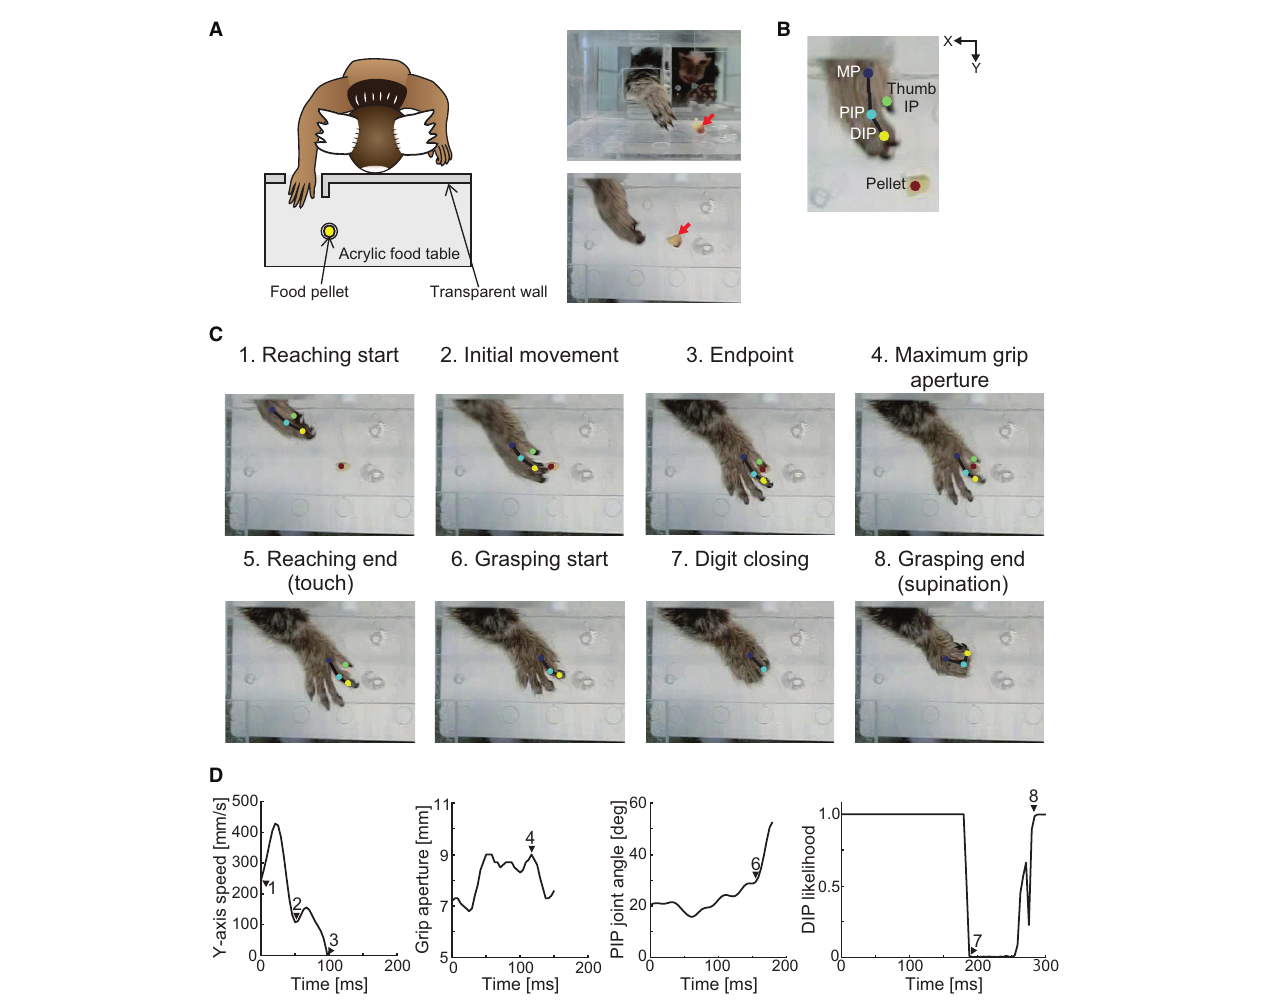
FIGURE1 Schematic of the experimental setup and definition of the movement phase. (A) Experimental setup. Red arrows in the right images indicate the position of the food pellet. (B) Positions of the tracking using DeepLabCut. Two-dimensional positions of the distal interphalangeal (DIP), proximal interphalangeal (PIP), and metacarpophalangeal (MP) joints of the index finger, interphalangeal (IP) joint of the thumb, and food pellet were tracked. (C) Definition of the movement phases. The reaching movement phase was defined as the time at which the MP joint of the index finger passed the opening (“reaching start”) to the time when the hand touched the food pellet (“reaching end”). The grasping movement phase was defined as the time at which the index finger started to flex (“grasping start”) to the time when the wrist began to supinate (“grasping end”). (D) Y-axis movement speed, grip aperture, PIP joint angle, and likelihood estimates of the index finger DIP joint position for each data point using DeepLabCut. Each number corresponds to those in (C)